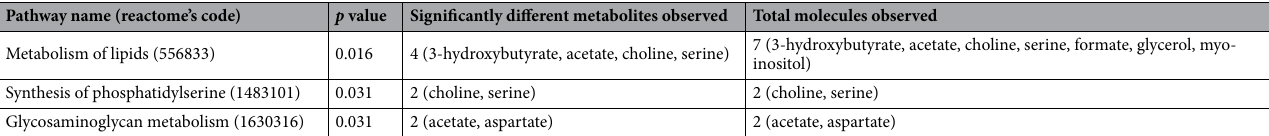
Table 3. Overrepresentation analysis (ORA) based on the metabolites significantly different between healthy (G0) and hyperketonemic (G2)